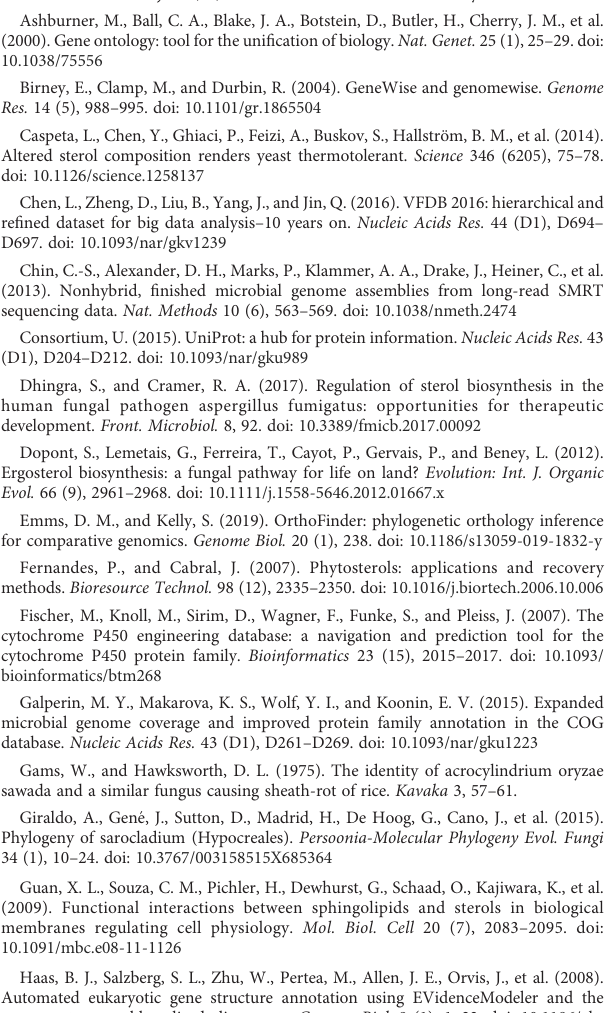
SUPPLEMENTARY FIGURE 1 GO function and KEEG pathway enrichment analyses in responding to the two type media of S. terricola . (A) differentially expressed genes number of the most enriched GO term, (B) differentially expressed genes number of the most enriched KEGG